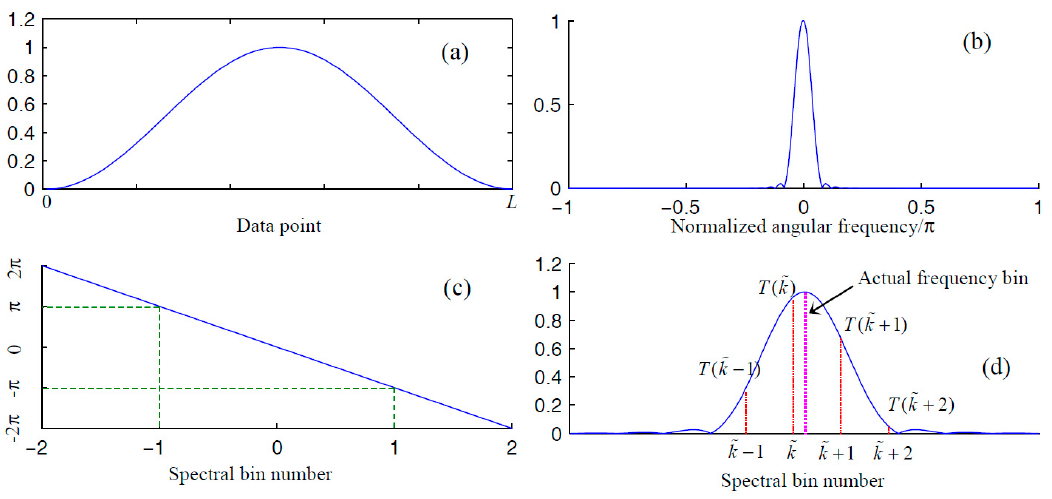
Figure 3. Fundamental principles of Hanning-window-based spectral correction method. ( a ) The magnitude response; ( b ) a zoomed-in plot of the magnitude response; ( c ) the phase response; and ( d ) the FFT grids compared with the magnitude response. The plot of modulus function in Equation (23) is shown in Figure